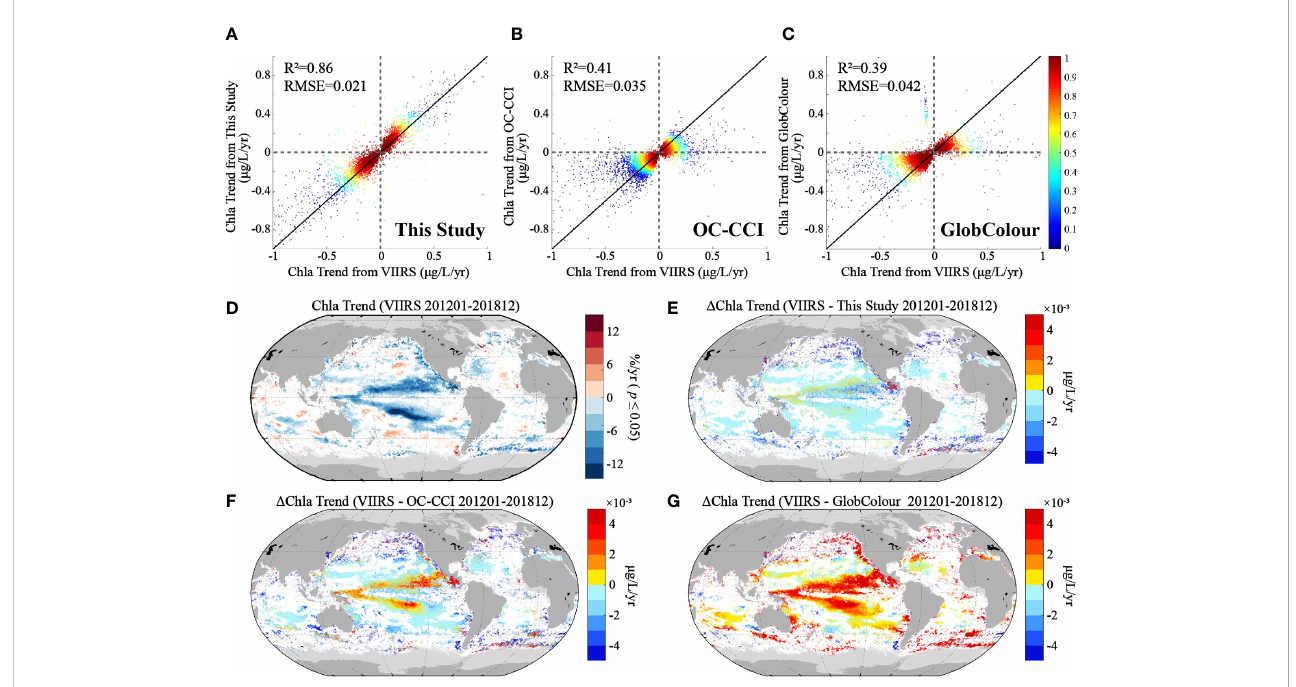
FIGURE 7 Pixel-by-pixel comparison of the Chla rate of change from VIIRS and (A) this study, (B) OC-CCI, and (C) GlobColour. (D) Chla trend maps in units of %/yr from VIIRS for January 2012 to December 2018. (E – G) Chla trends from VIIRS minus that from the three merged datasets in units of m g/L/yr. Black lines on the scatter plots represent the 1:1 line, and the color scale indicates the data density in pixels. The bright gray on the maps represents insuf fi cient data for trend estimation (i.e., the number of valid data collected in the statistical period (41 months) does not reach 50%), and white indicates that the VIIRS data show that the pixel has not changed signi fi cantly ( p < 0.05).